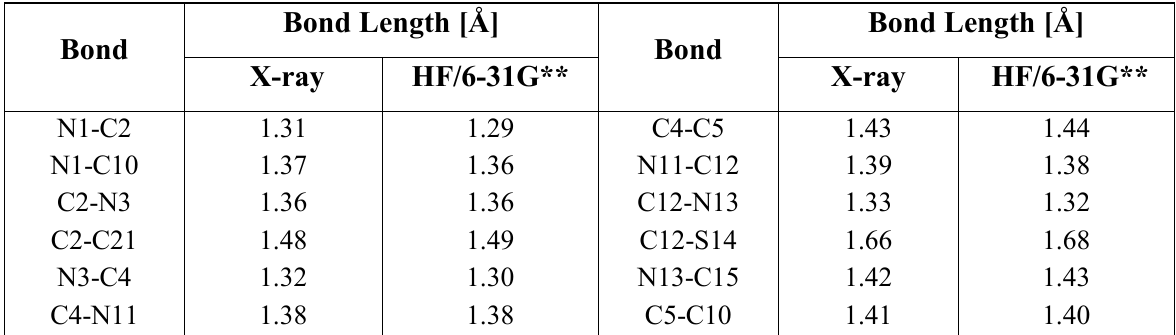
Table 1. Selected interatomic distances in 7f .